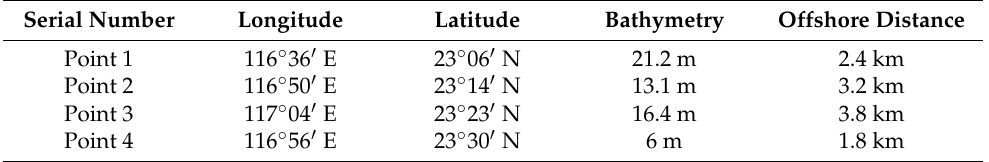
Figure 15. The water level distribution and flow field of typhoon crossing with different recurrence periods. Table 7. Location, bathymetry, and offshore distance of 4 control